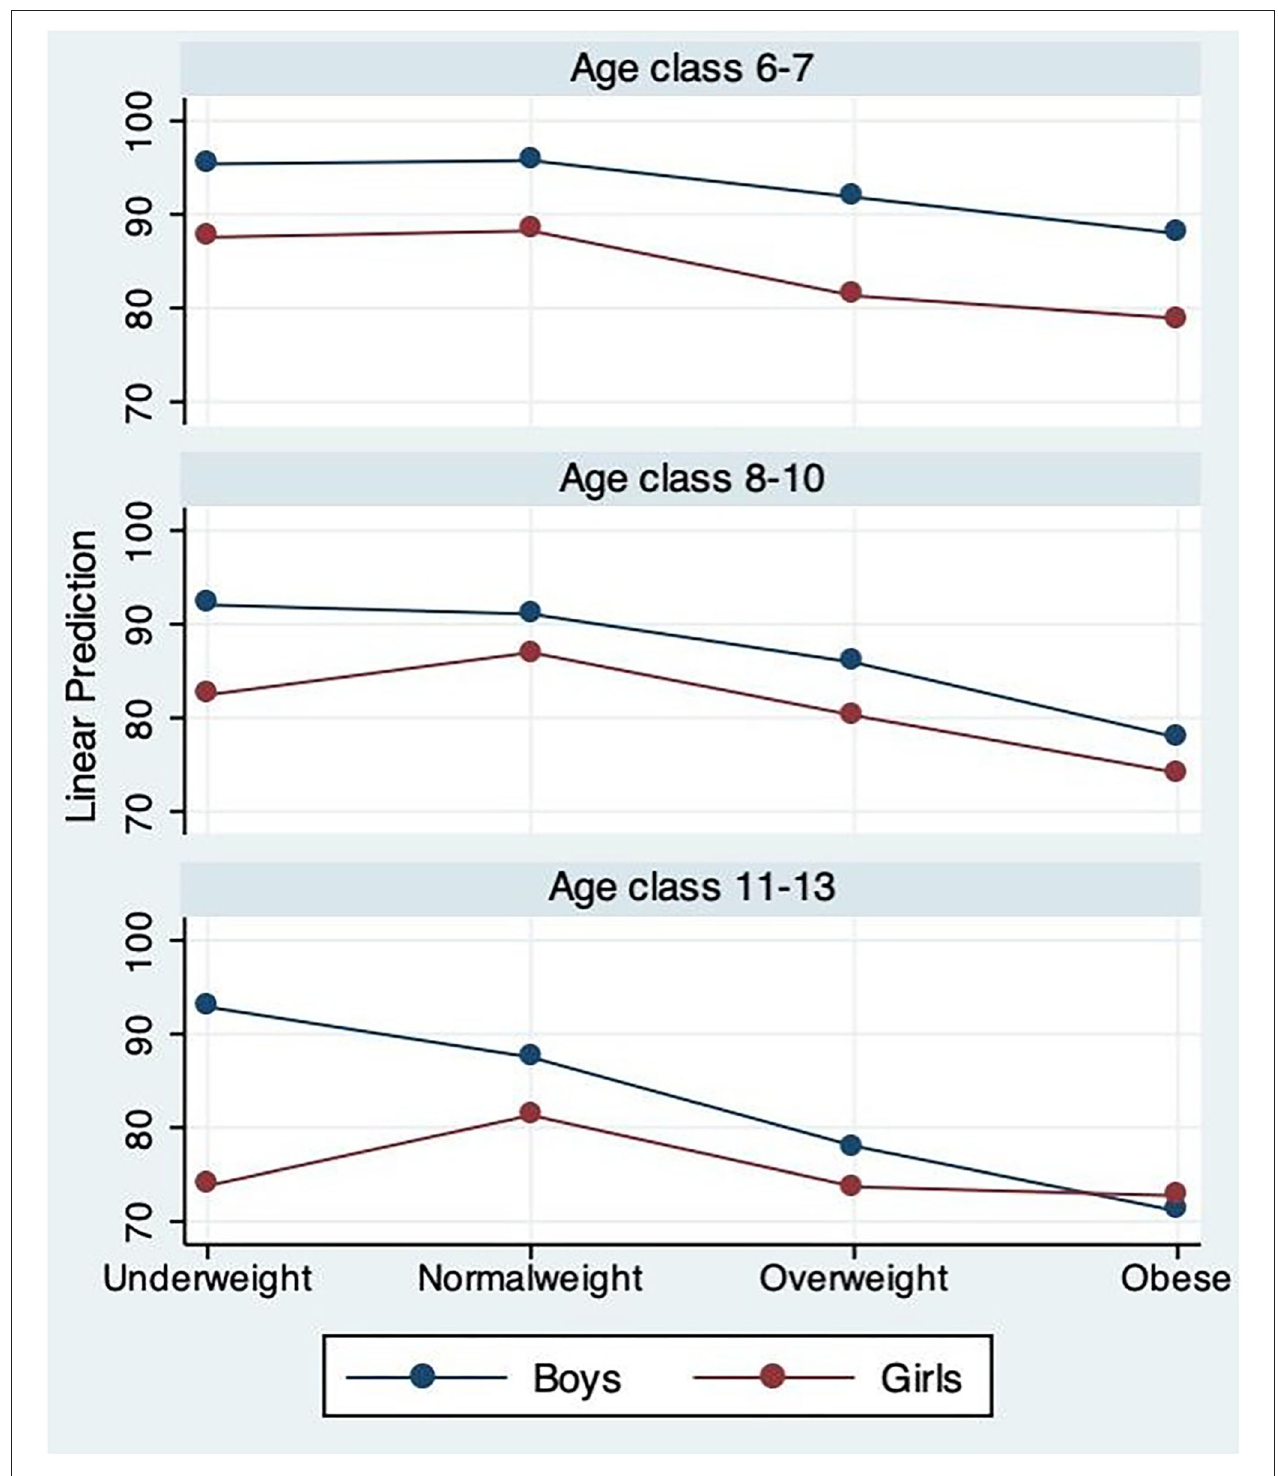
FIGURE 1 | Adjusted predictions of weight status-age-gender on MQ.